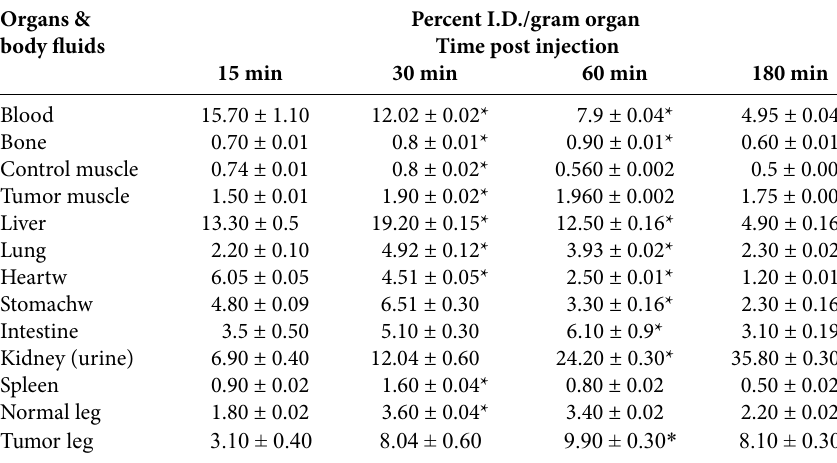
Table 11. Biodistribution of 125 I- TP 5 in solid tumor bearing